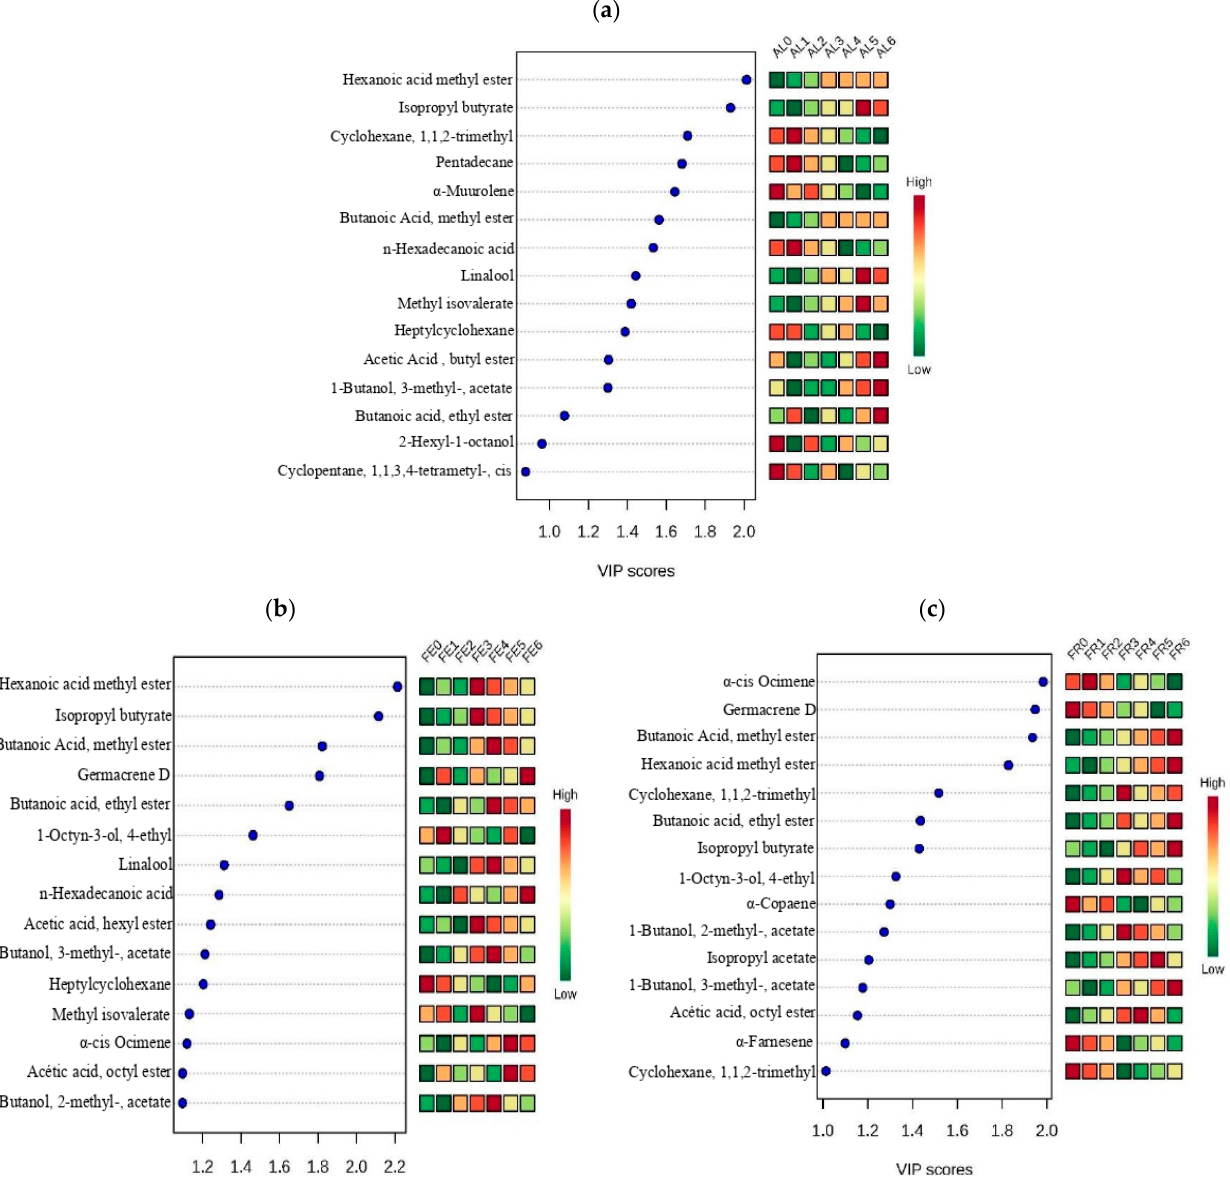
Figure 2. Variable importance in projection (VIP) graph showing the 15 most important VOCs in descending order. The degree of importance during each phenological stage is shown by the color gradient, in which red indicates a high correlation and green a low correlation. VIP score is a measure of a variable’s importance. ( a ) VIP var. Albion; ( b ) VIP var. Festival; ( c ) VIP var. Frontera.